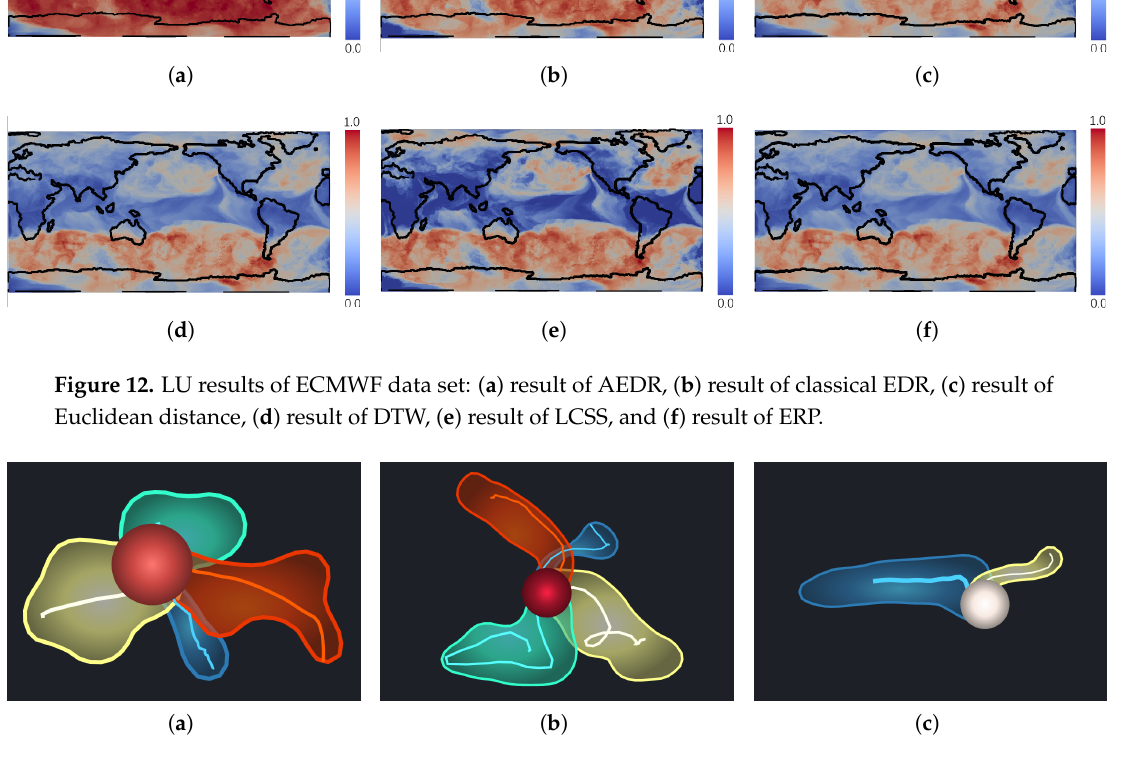
Figure 13. Transport patterns of marked locations in Figure 12a: ( a ) transport pattern at location “A”, ( b ) transport pattern at location “B”, and ( c ) transport pattern of location